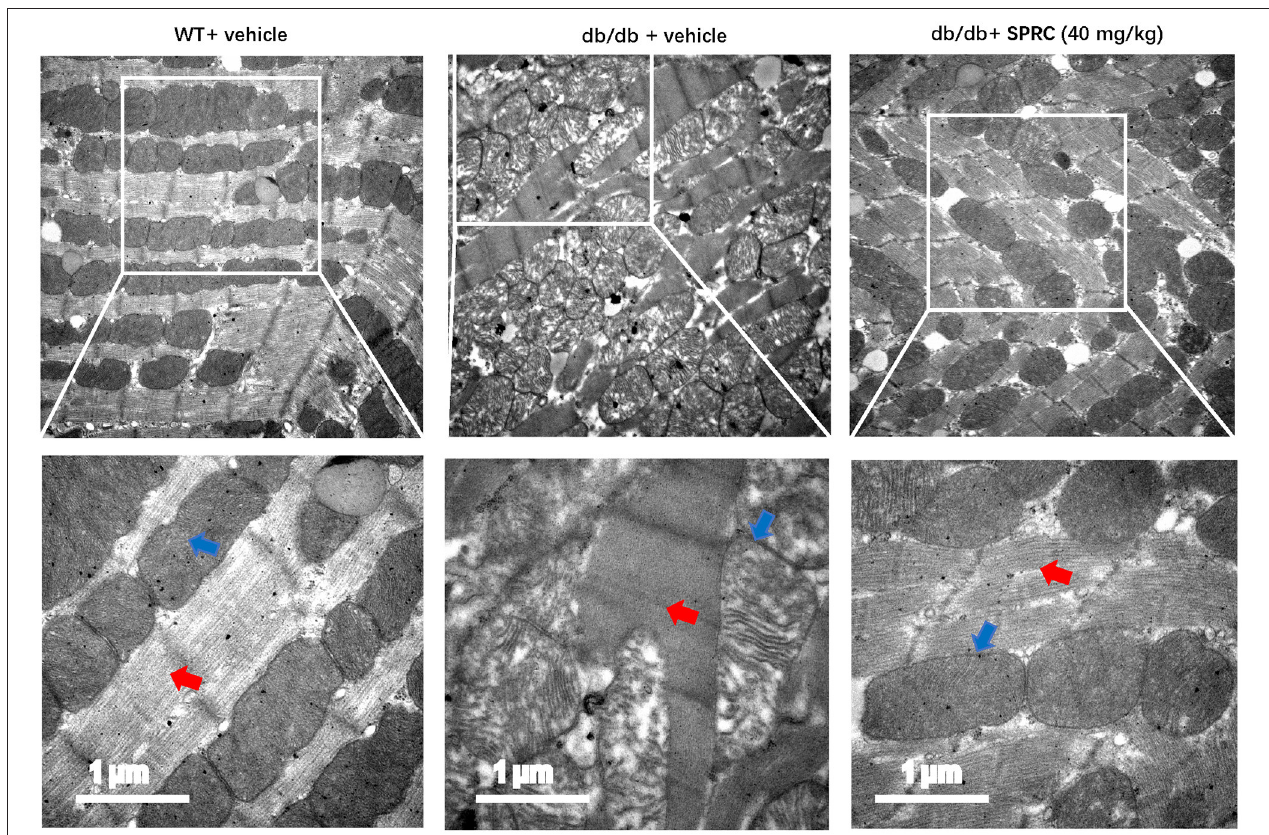
FIGURE 3 | SPRC treatment improves abnormal ultrastructure of cardiomyocytes in db/db mice. Vehicle or SPRC (20,40, or 80 mg/kg/day) was orally administered to WT mice or db/db mice for 12 weeks. Heart tissue specimens were collected and representative images of the ultrastructural morphology of cardiomyocytes were shown. The red arrow indicates myofilament and the blue arrow indicates mitochondria ( n =